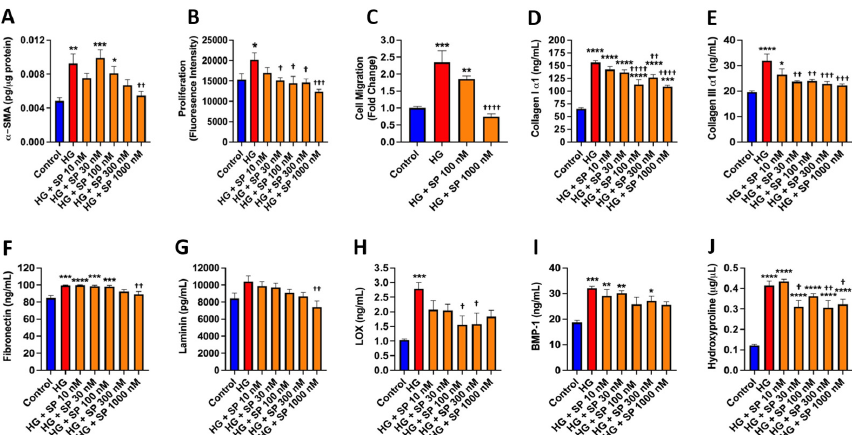
Figure 2. SP opposes the effects of high glucose on cardiac fibroblast phenotype and function. Isolated mouse cardiac fibroblast ( A ) α -smooth muscle actin ( α -SMA) in cell lysate; ( B ) cellular proliferation; ( C ) and cell migration in response to normal glucose (Control, 5 mM), high glucose (HG, 25 mM), and HG with increasing concentrations of SP (10 to 1000 nM). ( D ) collagen I α 1; ( E ) collagen III α 1; ( F ) fibronectin; ( G ) laminin; ( H ) lysyl oxidase (LOX); and ( I ) bone morphogenic protein-1 (BMP-1) measured in the cell culture media from isolated cardiac fibroblasts in response to control, HG, and HG with increasing concentrations of SP (10 to 1000 nM). ( J ) hydroxyproline measured in the media from cultured human cardiac fibroblasts in response to control, HG, and HG with increasing concentrations of SP (10 to 1000 nM). Data are expressed as mean ± SEM and were analyzed by one-way ANOVA with Tukey post hoc test; * p < 0.05 vs. control, ** p < 0.01 vs. control, *** p < 0.001 vs. control, **** p < 0.0001 vs. control, † p < 0.05 vs. HG, †† p < 0.01 vs. HG, ††† p < 0.001 vs. HG, †††† p < 0.0001 vs. HG. n = 4–6 for control and n = 5–6 for all other groups.